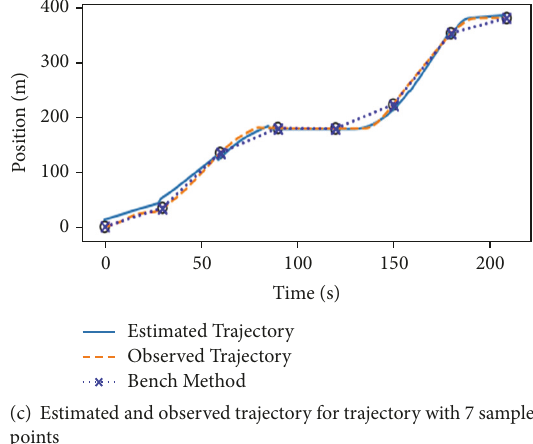
below 7, the stop position range has no effect on the MMAE. However, when the number is above 6, the MMAE increases with the distance from the stop position to the intersec-